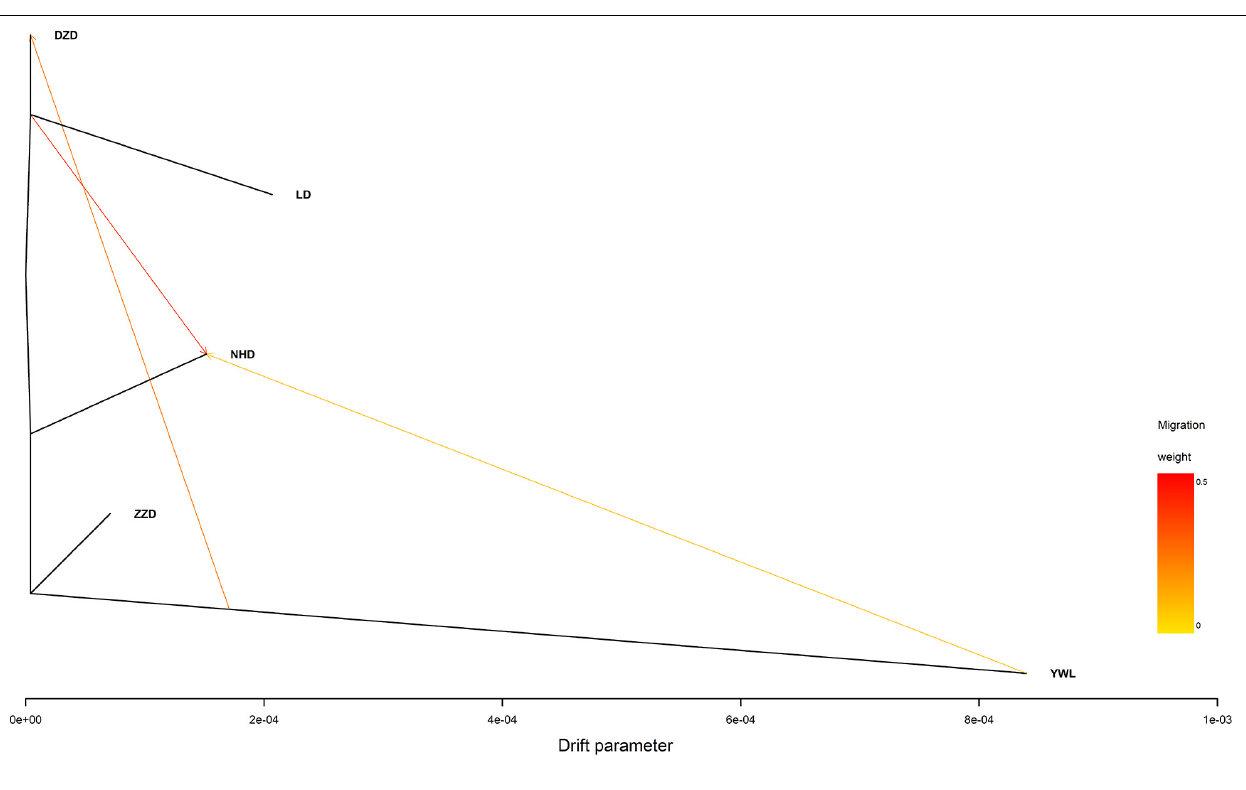
FIGURE 5 | Population-level phylogeny with migration edges constructed using